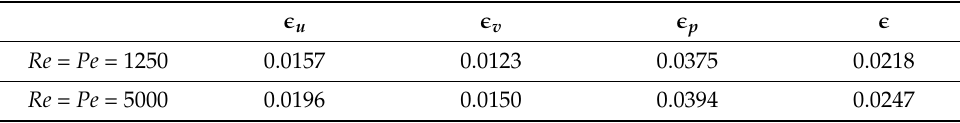
Table 4. The percentage form of error in Re = Pe = 1250.